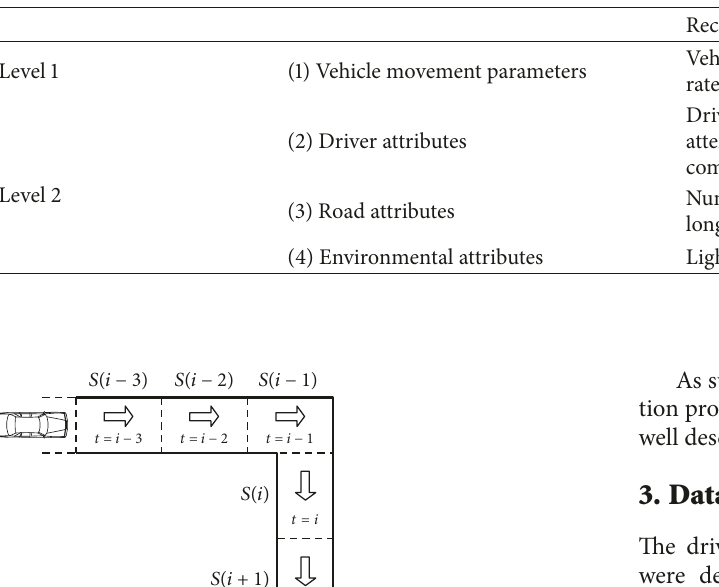
Table 1: Retrieved risk-related attributes from “100-car” NDS dataset.